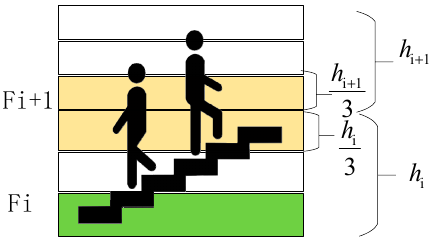
Figure 4. Floor prediction processing.